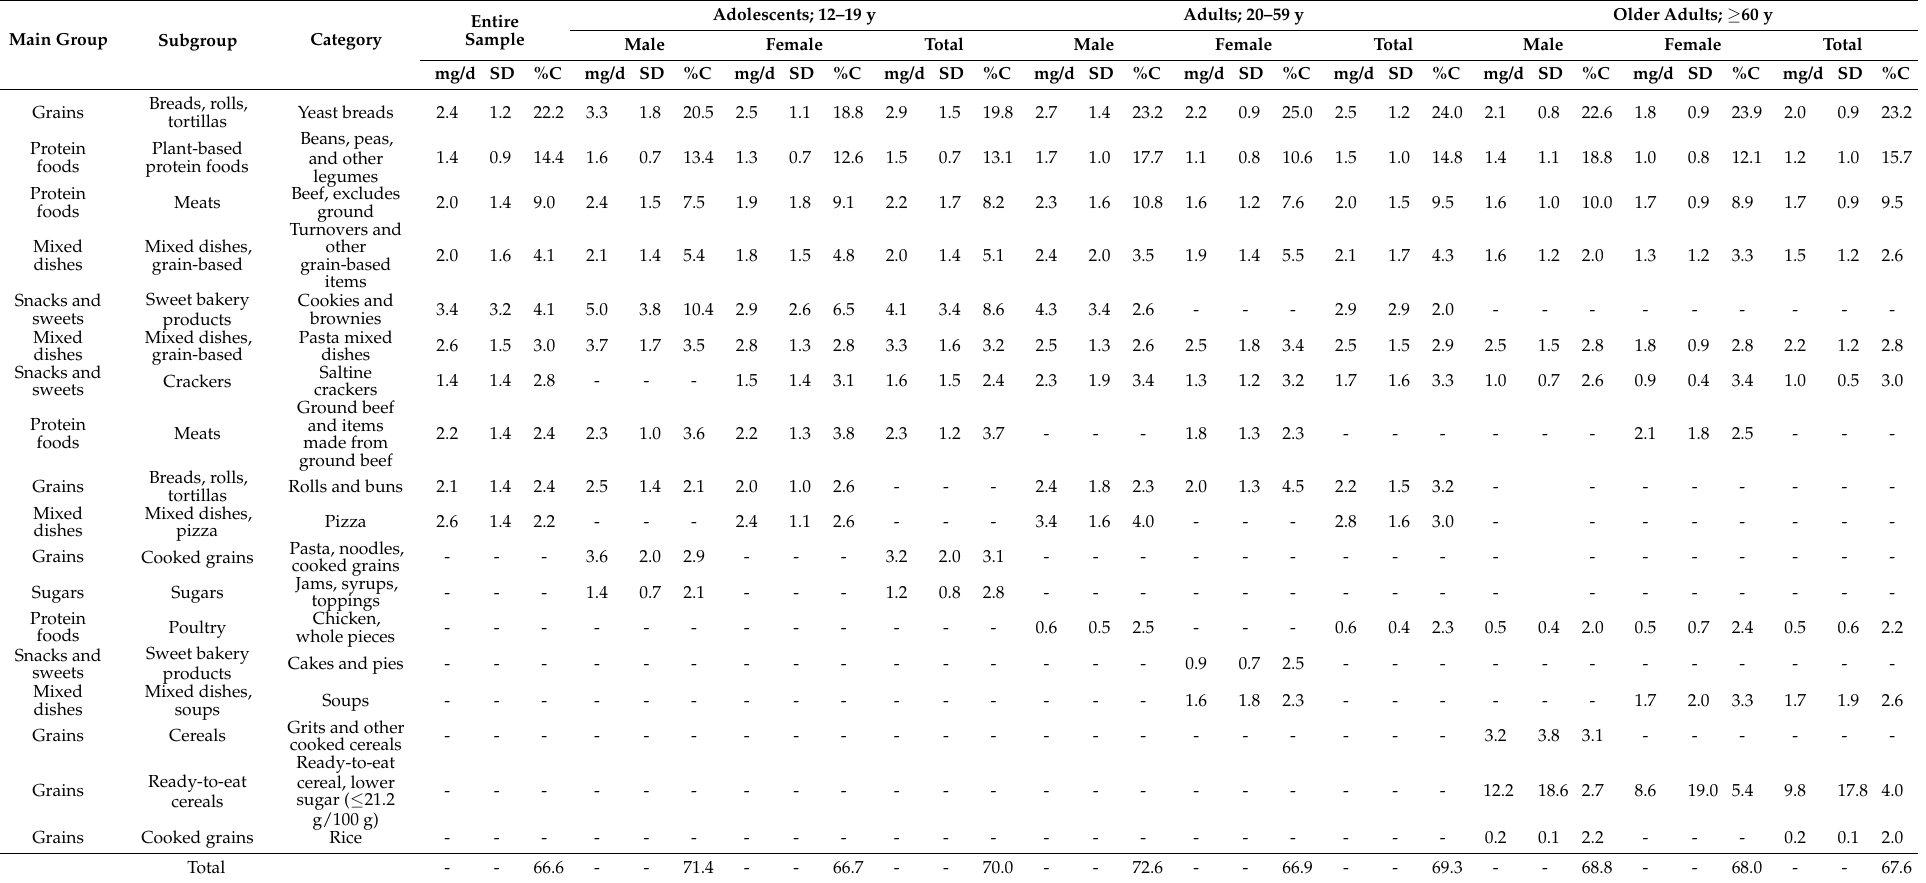
Table 4. Top ten food contributors to dietary iron intake among residents of the urban area of S ã o Paulo: 2015 Health Survey of S ã o